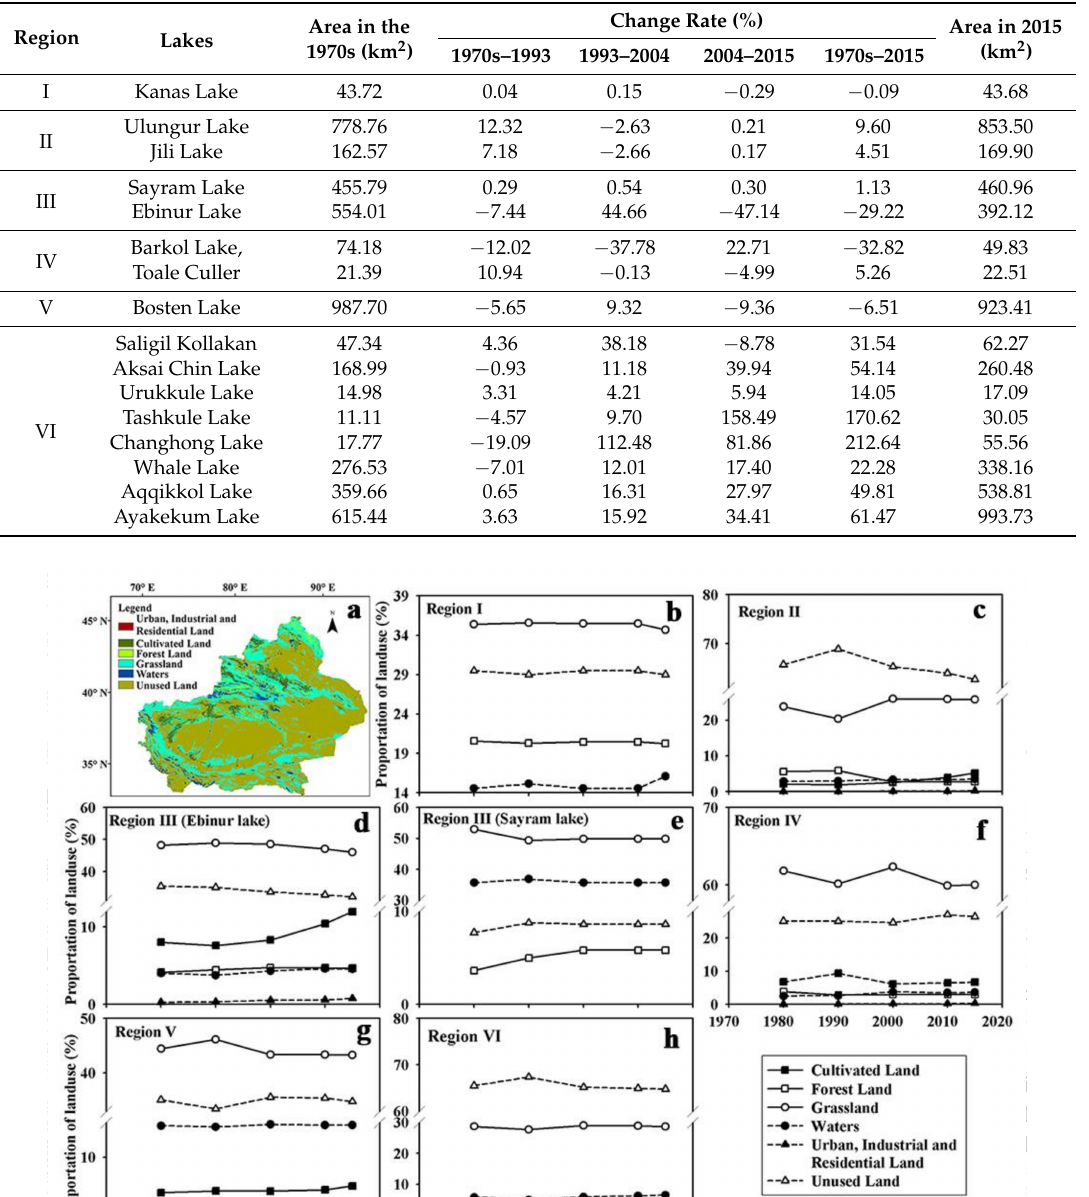
Table 1. Basic information on lakes in the six regions and the changing rates of lake areas in the past 45 years.